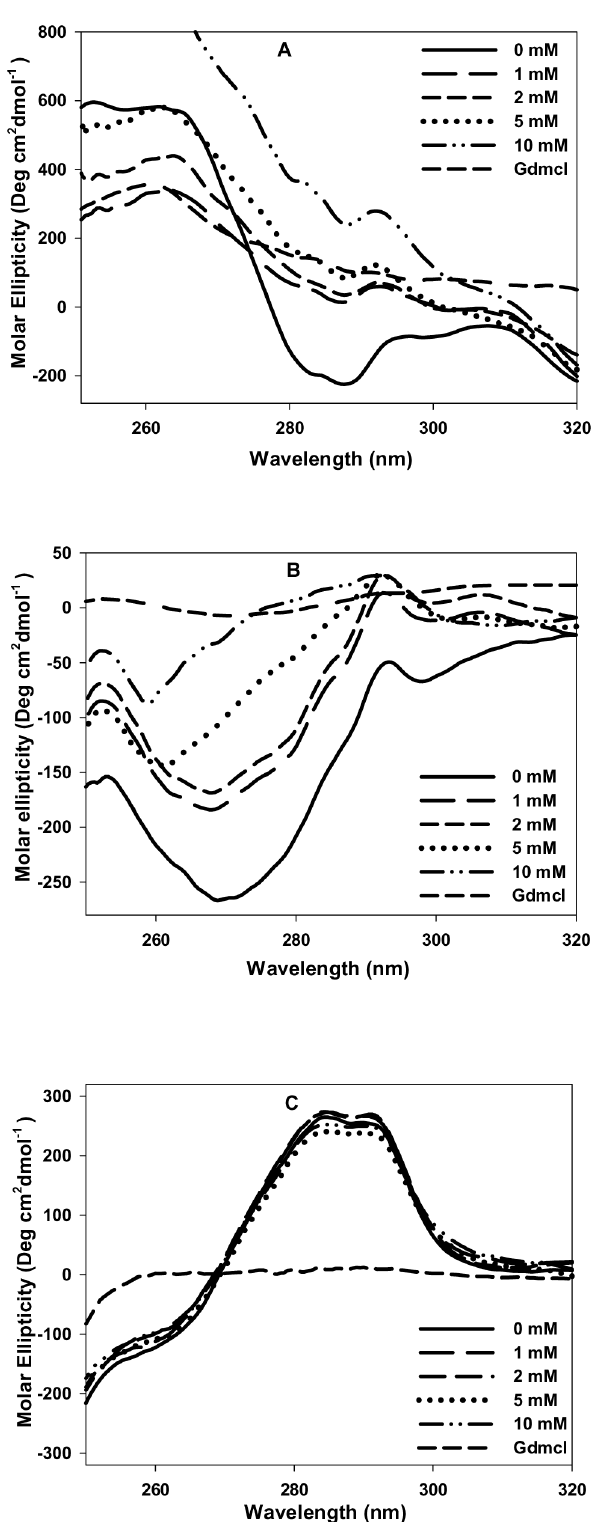
Figure 3. Effect of homocysteine thiolactone (HTL) on the tertiary structure of the native state of proteins. Near UV CD spectra of (A) cyt-c (at 18 hours), (B) a -LA (at 4 hours) and (C) Lysozyme (at 24 hours) modified with different concentrations of HTL. Unfolded state control (7.0 M GdmCl) have also been shown for each protein.